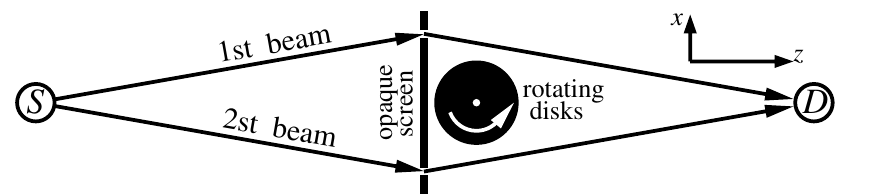
Figure 16. Scheme of the Aharonov–Bohm experiment for the two massive rotating disks placed in a deep vacuum. Two neutron beams from source S pass through two slits in an opaque screen and converge on detector D where the interference fringes form. The rotating disks are between the neutron beams in a screen